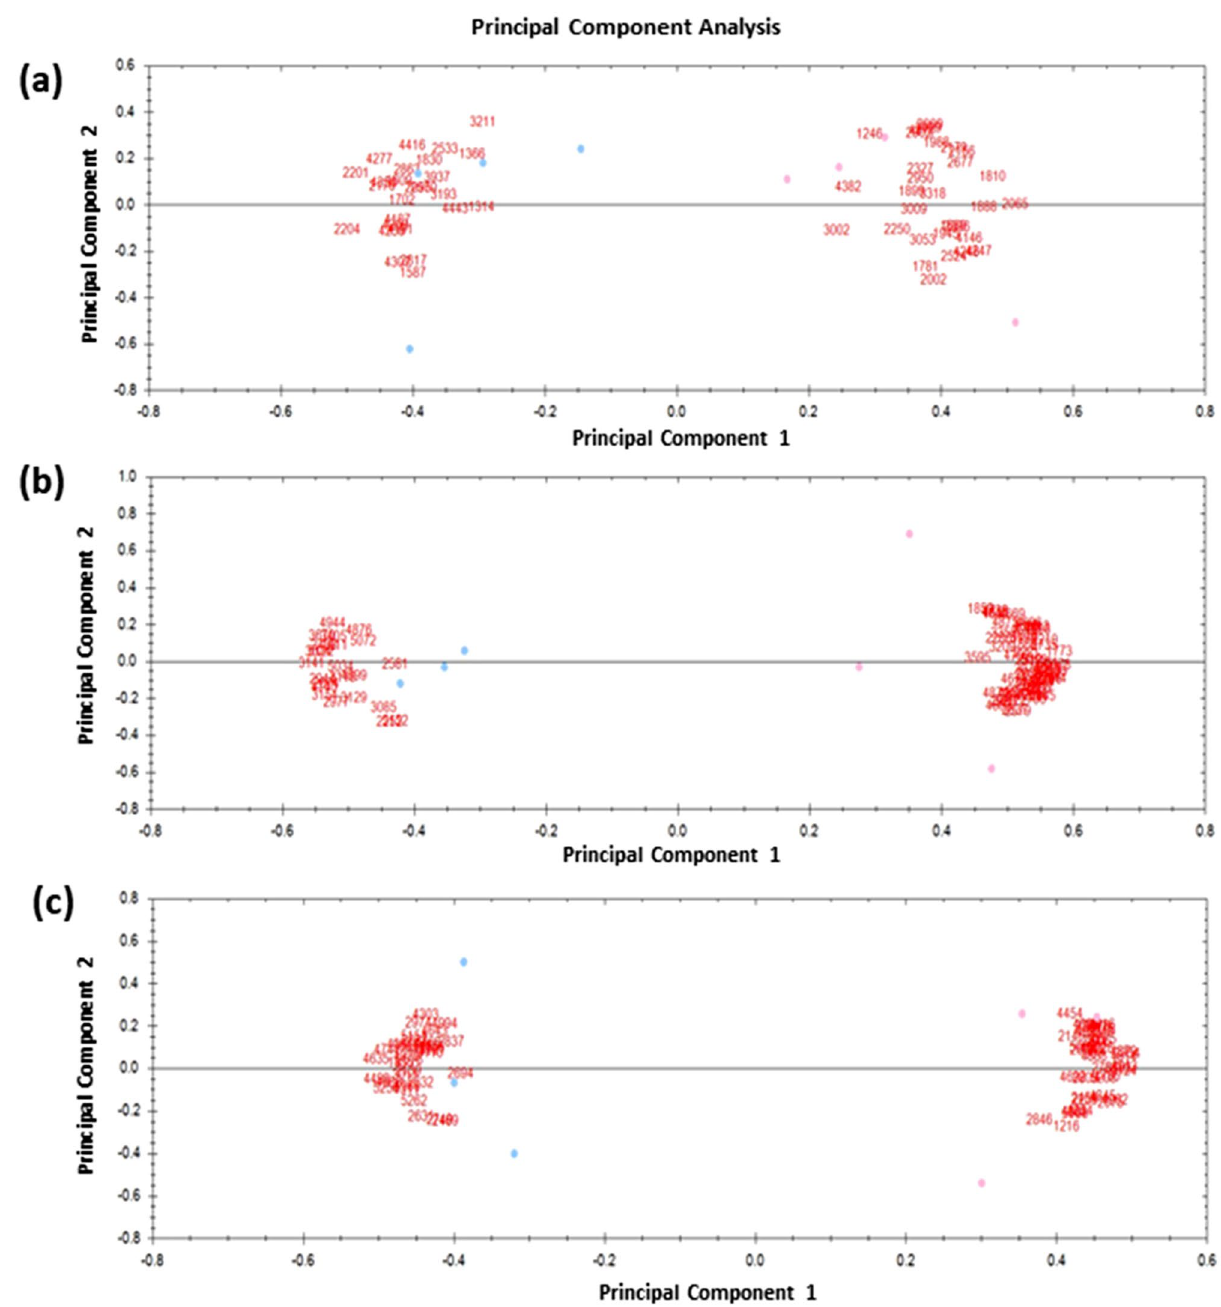
Figure 2. PCA changes in abundance of proteins spots. The 2D gel images were grouped per dietary inclusion of T. molitor (TM) meal for ( a ) gilthead seabream ( Sparus aurata ), ( b ) European seabass ( Dicentrarchus labrax ) and ( c ) rainbow trout ( Oncorhynchus mykiss ). The locations of the significantly different protein spots (expressed as mean normalised values) [Progenesis SameSpots version 4.5 (Non-linear Dynamics, Newcastle upon Tyne, UK www. nonli near. com)] from four or five gel images per dietary treatment were